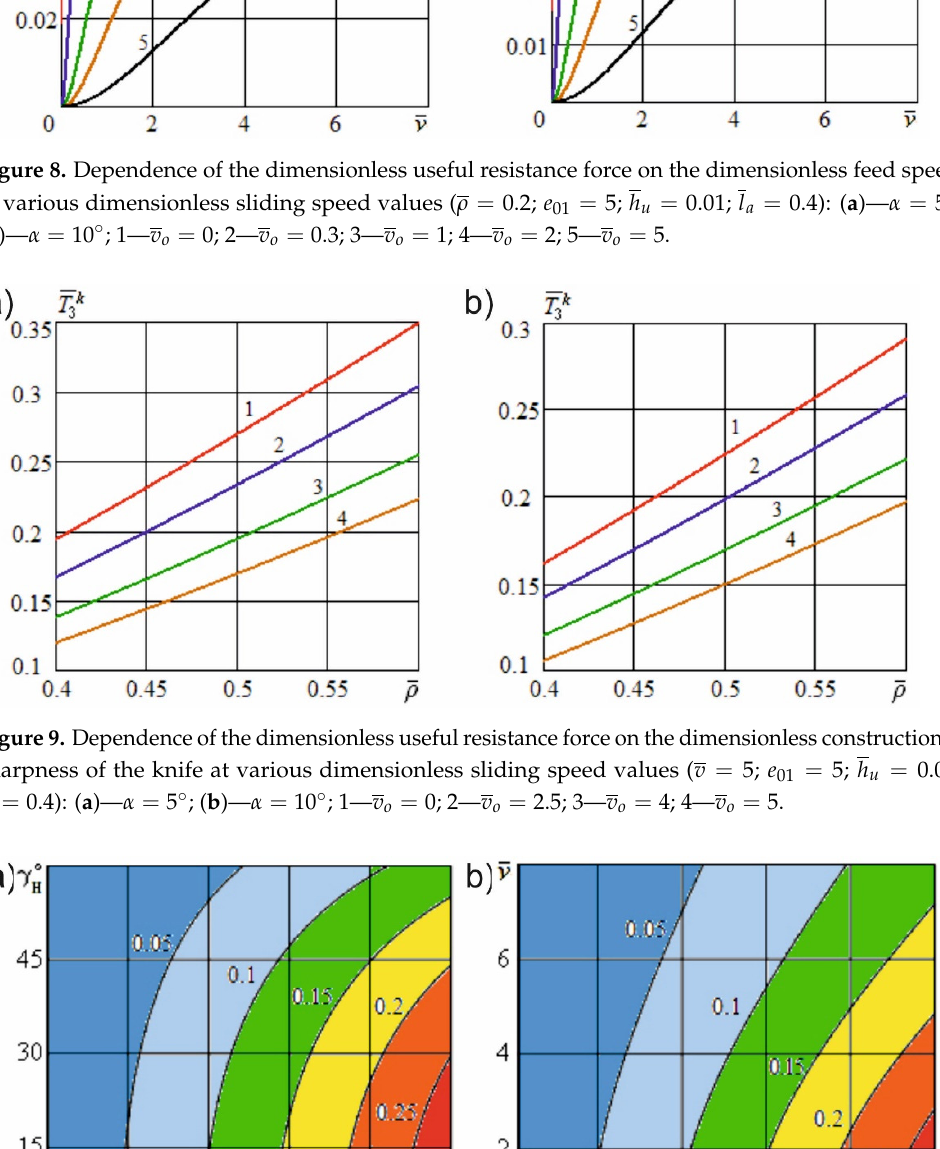
Figure 8. Dependence of the dimensionless useful resistance force on the dimensionless feed speed